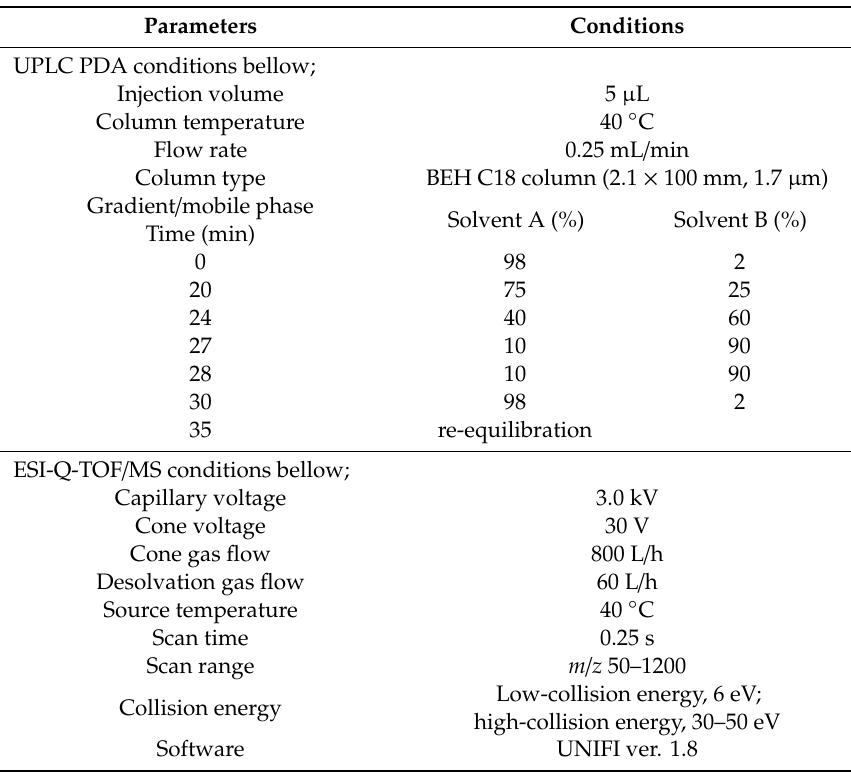
Table 4. UPLC-PDA / ESI-Q-TOF / MS operating